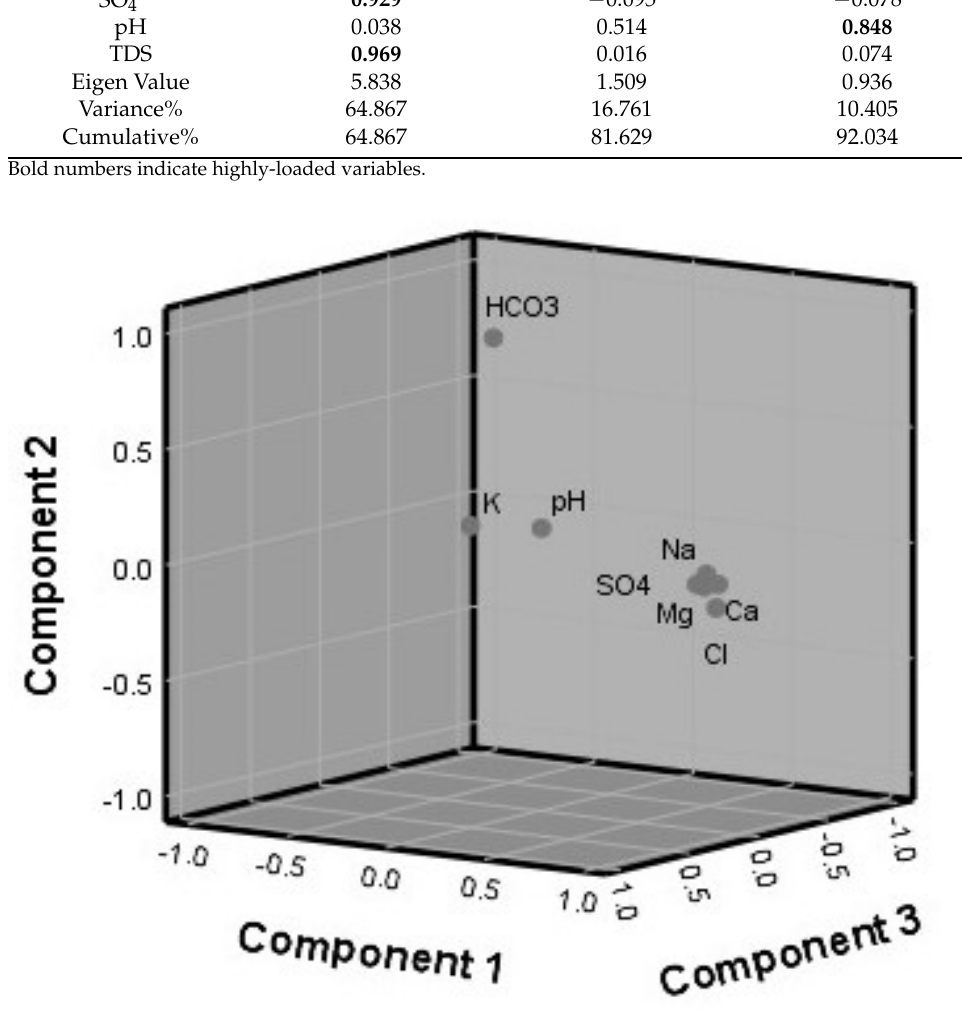
Figure 7. Water types of the studied water samples.